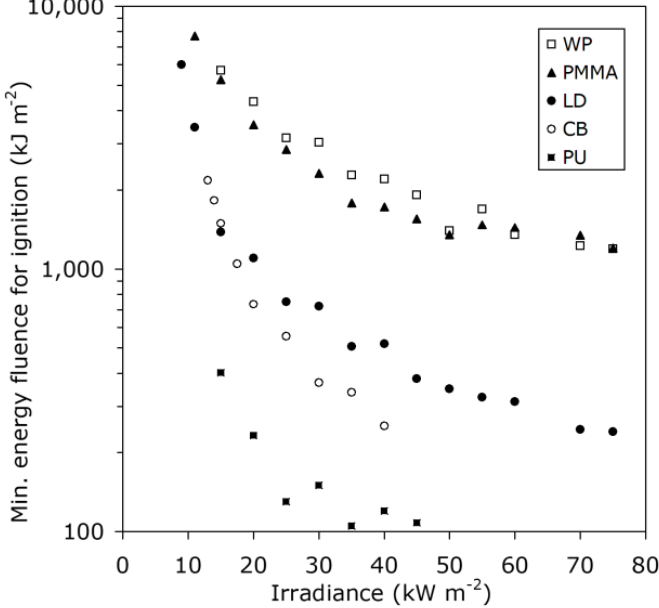
Figure 10. Minimum energy fluence for some thermally thick solids [6] (WP, wood particleboard; PMMA, polymethylmethacrylate; LD, low-density fiberboard; CB, cardboard; PU, polyurethane foam) .